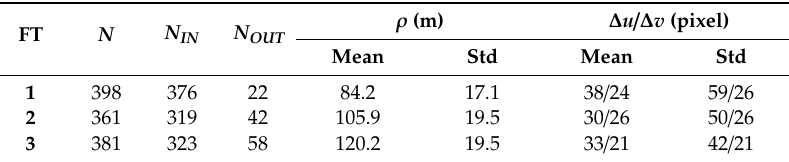
Table 1. Statistics of the FTs for database